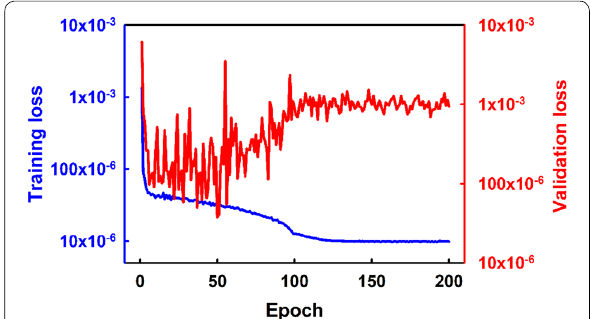
Fig. 2 Training loss and validation loss as the model trains. The code monitors the model’s progress and saves the model with the lowest loss on the validation dataset as the best model. Both of the y-axis curves are shown on a logarithmic